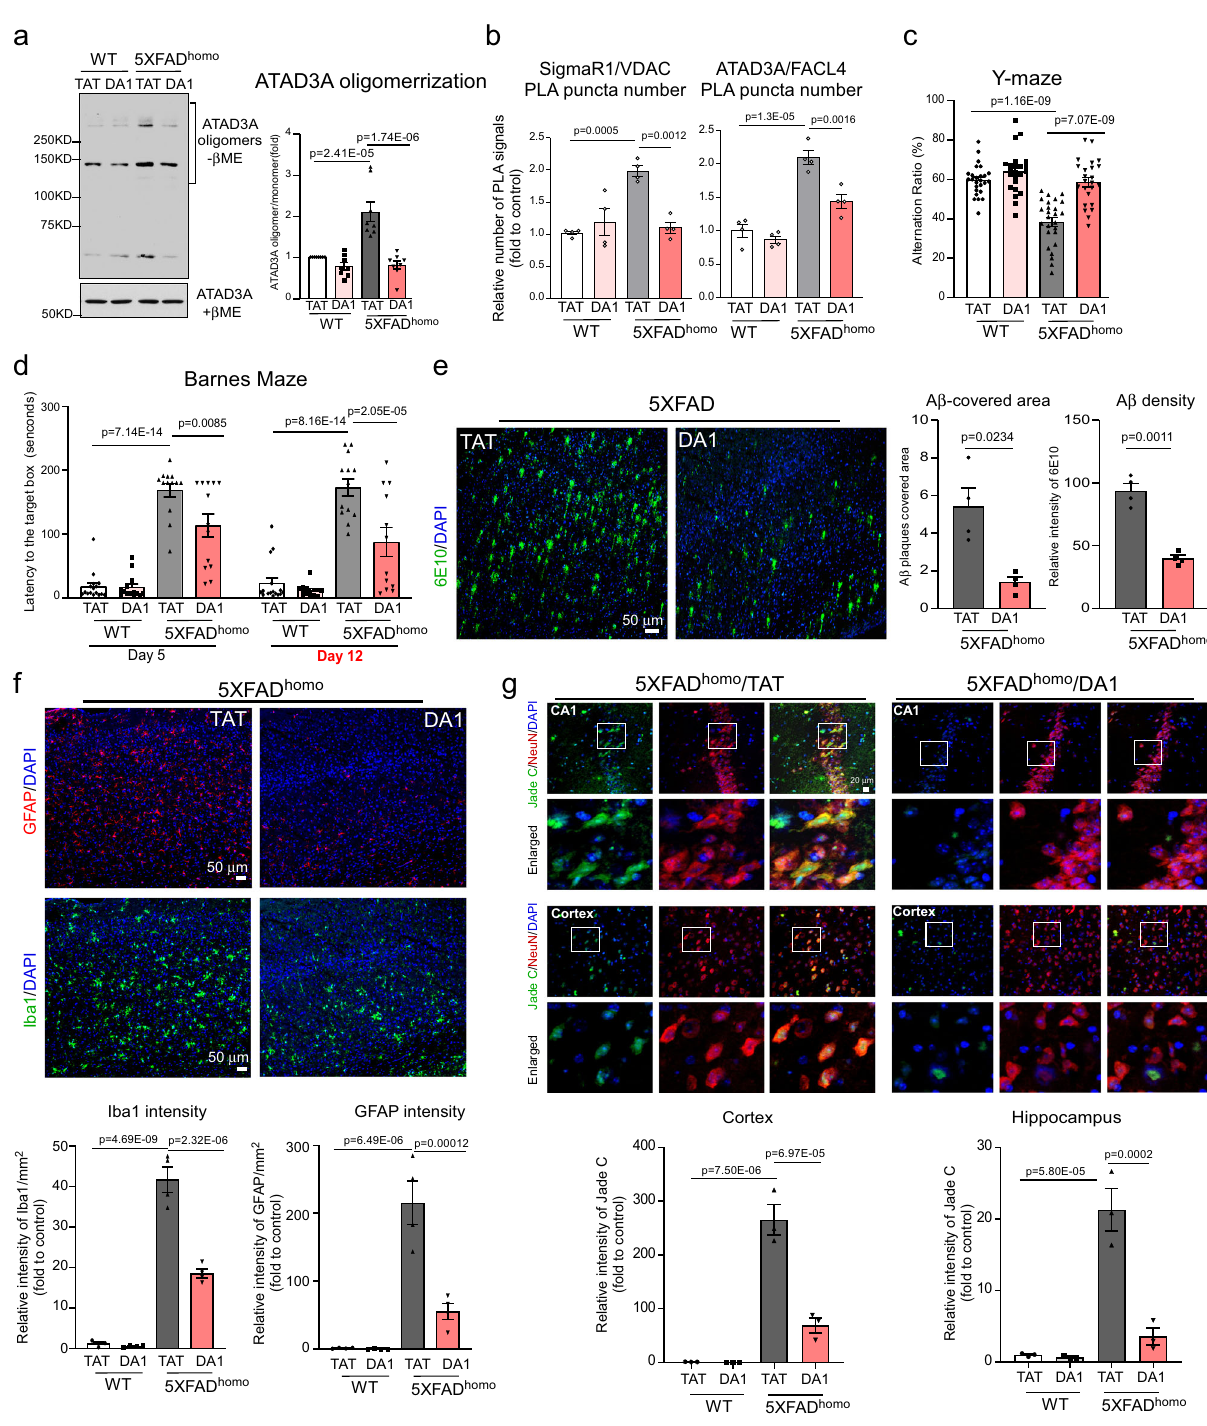
however, this effect was signi fi cantly reduced in heterozygous ATAD3A knockout 5XFAD mice (Fig. 5f). Moreover, DA1 reduced the cholesterol content in the cortex of 5XFAD homo mice compared to that of AD mice treated with control peptide (Fig. 5g). Filipin is a commonly used fl uorescence probe to monitor cholesterol deposition in cells and brain tissue 46 . We observed a signi fi cant accumulation of fi lipin-bound cholesterol in 9-month-old 5XFAD homo mouse brains and stable APP- expressing Neuro2a cells relative to their WT counterparts. Furthermore, inhibition of ATAD3A oligomerization by DA1 reduced cholesterol deposition (Fig. 5h, Supplementary Fig.